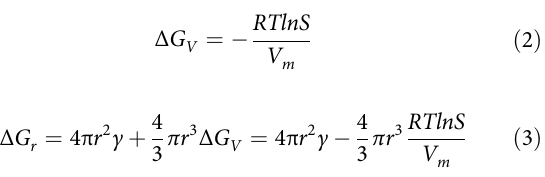
Where r is the nucleation radius, γ is surface free energy in per unit area, R is the ideal gas constant, Δ G V is the free energy gap for per unit volume of metal solids and solute particles, T is the temperature for nucleation, V m is solid molar volume, S is the ratio of supersaturation concentration to equilibrium concentra- tion, and Δ G r is excess free energy, which is related with the surface energy (4 π r 2 γ ) and volume free energy (4/3) π r 3 Δ G V .